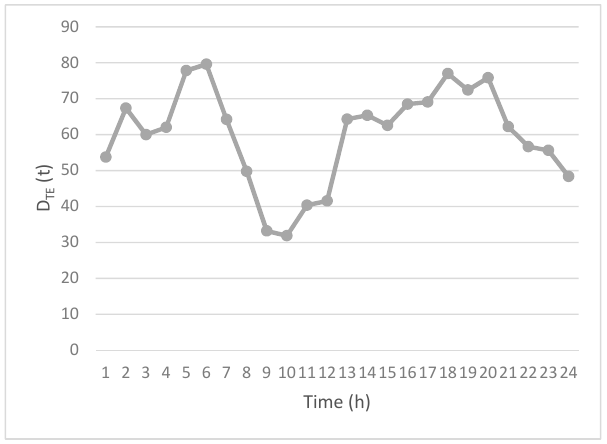
Figure 5. Process steam demand .